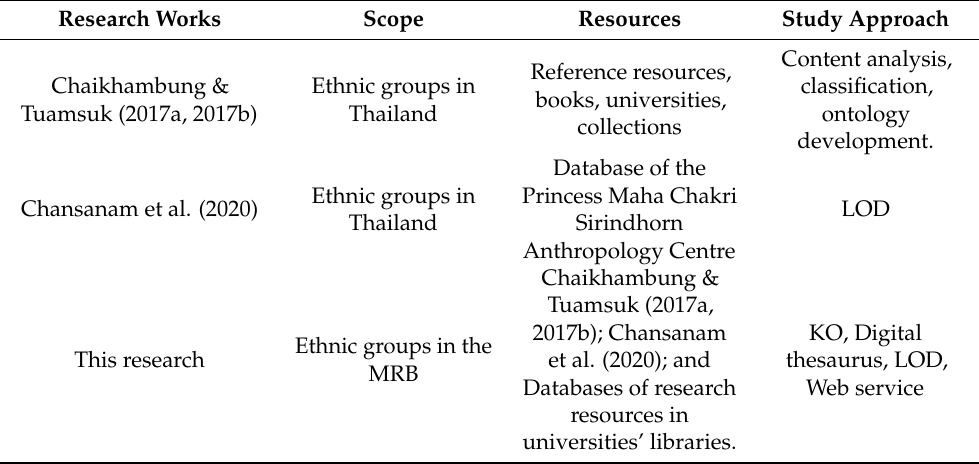
Table 4. Comparison of the research works on ethnic group knowledge organization and